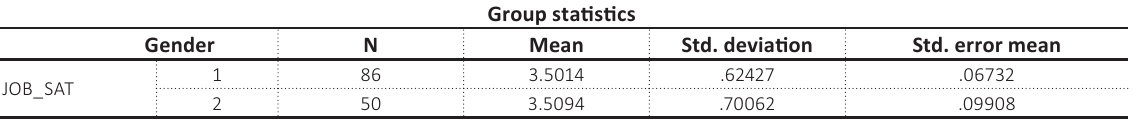
Table 14. Independent sample